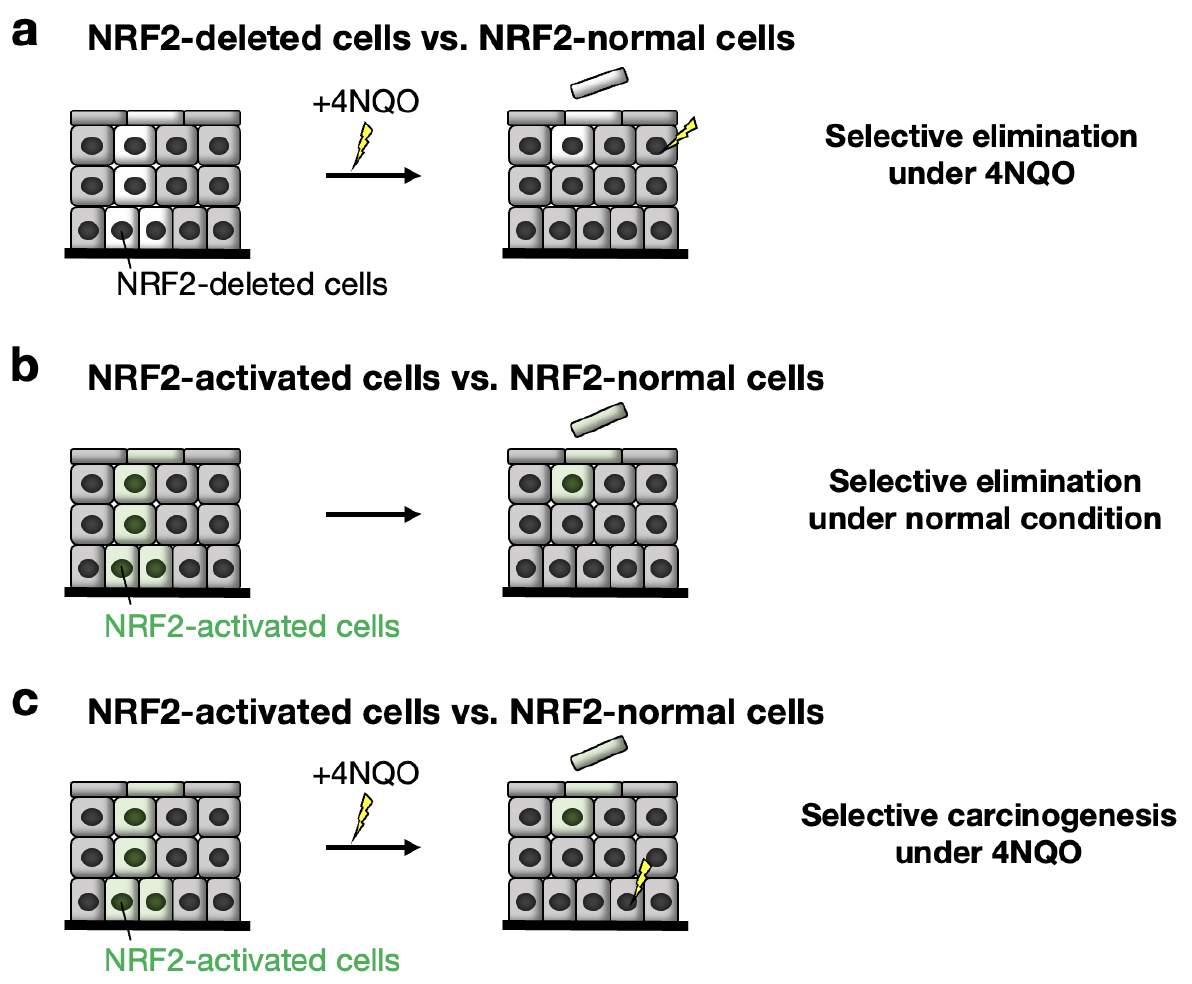
Figure 6. Fate of NRF2-deleted and NRF2-activated cells in the esophageal epithelium when colocalized with NRF2 and KEAP1 normal epithelial cells. The fate of these esophageal cells was examined after treatment with the carcinogen 4NQO (4-nitroquinoline-1-oxide). The results are well explained by the cell competition model (see text). ( a ) NRF2-deleted cells vs. NRF2-normal cells under 4NQO. Note that NRF2-deleted cells are eliminated from the esophageal epithelium under 4NQO administration. ( b ) NRF2-activated cells vs. NRF2-normal cells under 4NQO untreated conditions. Note that NRF2-activated cells are eliminated from the esophageal epithelium. ( c ) NRF2-activated cells vs. NRF2-normal cells under 4NQO. Note that NRF2-activated cells are eliminated from the esophageal epithelium. NRF2-normal cells are an origin of carcinogenesis under 4NQO administra-